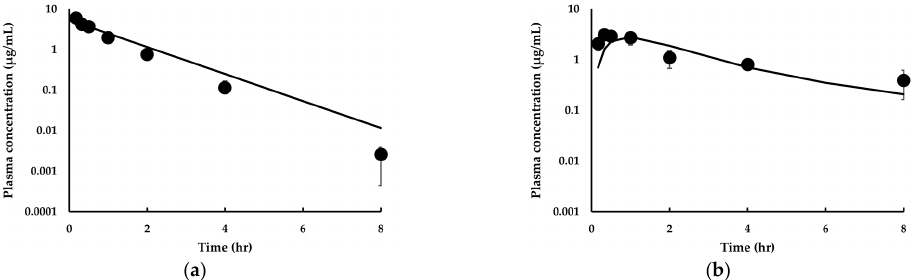
Figure 4. Observed and predicted time-concentration profiles for IDP-73152 following ( a ) 10 mg/kg intravenous and ( b ) 20 mg/kg oral administration in mice. Solid lines represent predicted data. Closed circles (•) represent observed data. Observed data are means (cid:3399) SD ( n = 3 mice for intrave- nous administration study, n = 4 mice for oral administration study). Table 4. Observed and predicted PK parameters of IDP-73152 in mice.